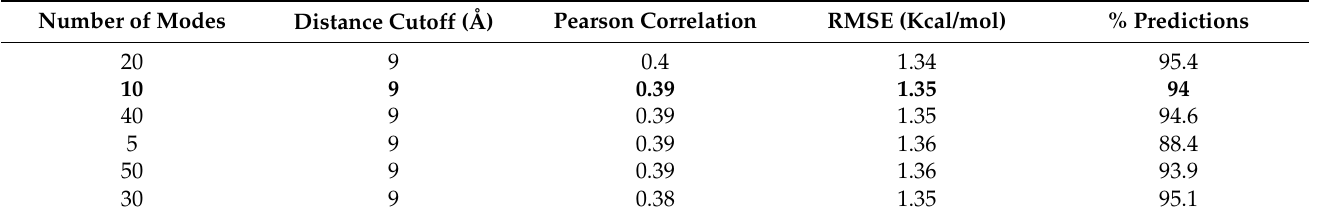
Table 2. Predictive performance of PSP-GNM for different low-frequency modes evaluated on the S2298 dataset. For all calculations, the distance cutoff was set to 9 Å. % Predictions is the percentage of mutations in the S2298 dataset with a calculated ∆∆ G. The best performance is shown in